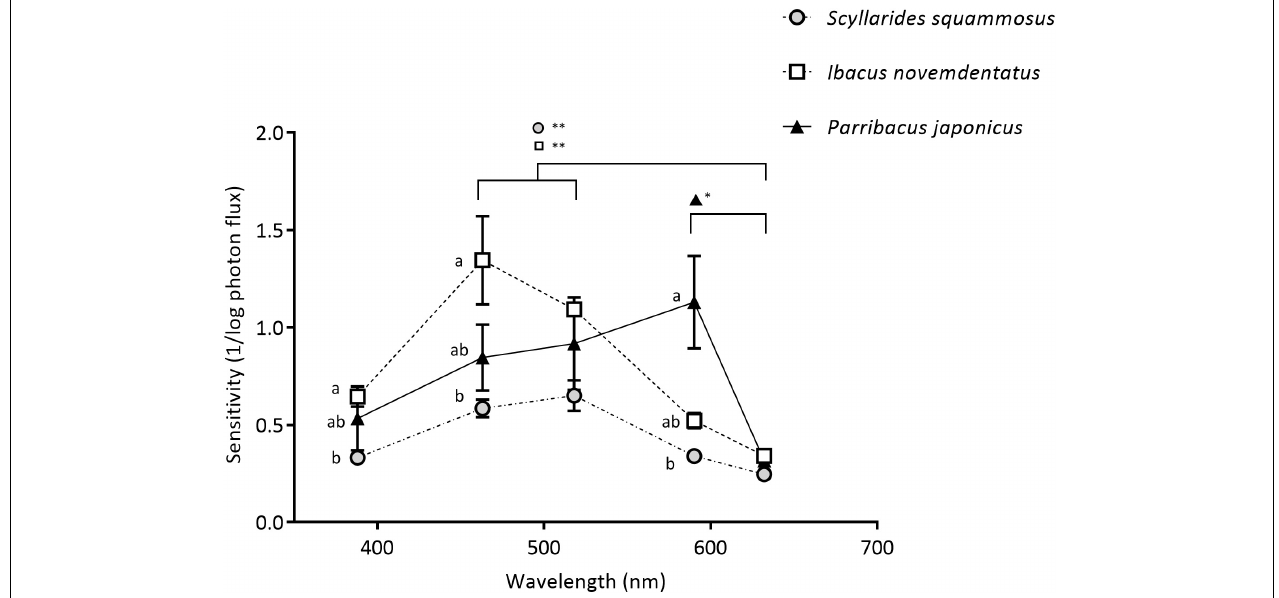
FIGURE 6 | ERG absolute spectral sensitivities. Dark-adapted spectral sensitivities were measured in S. squammosus ( n = 5), I. novemdentatus ( n = 5) and P. japonicas ( n = 6). Data are presented as the reciprocal of the intensity in log scale; mean ± SEM. ∗ p < 0.05 or ∗∗ p < 0.005 among the spectra. The symbols with different letters indicate a significant difference between species ( p <